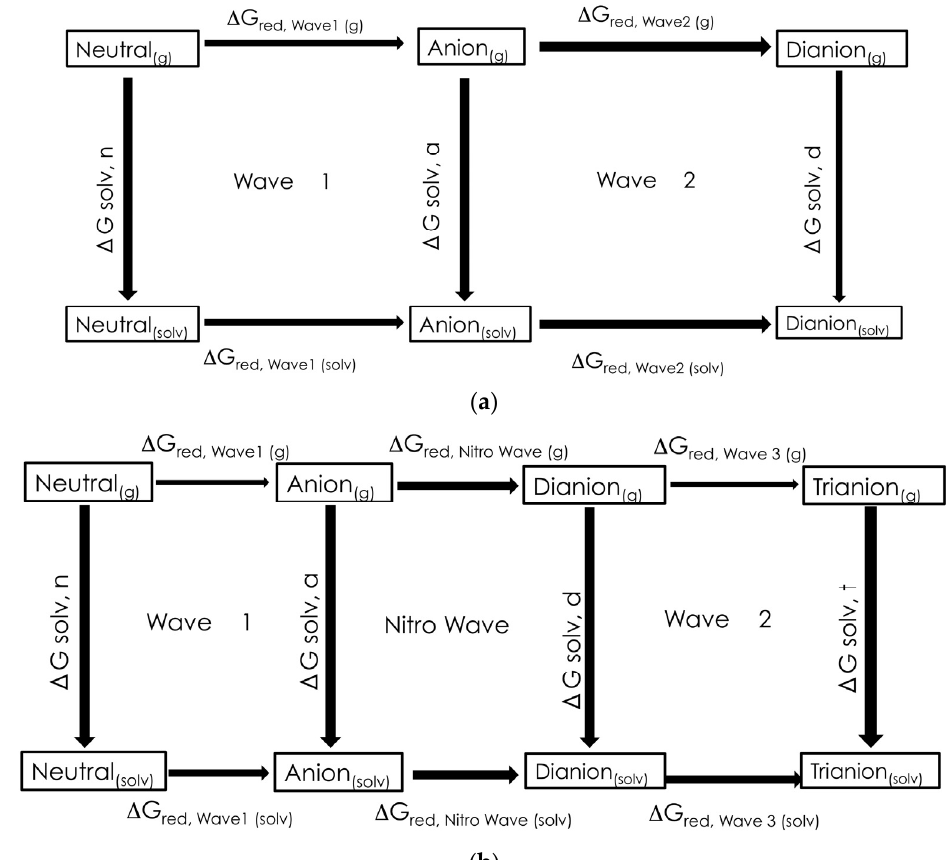
Figure 4. Visual representation of the thermodynamic cycles used to calculate the change in free energy of reduction ( ∆ G red ) : ( a ) wave 1 (first reduction of the diazine ring) and wave 2 (second reduction of the diazine ring) for derivatives without a nitro group (A1–D4) and ( b ) wave 1 (first reduction of the diazine ring), nitro wave (nitro group reduction) and wave 2 (second reduction of the diazine ring) for derivatives containing a nitro group (E1–E4).